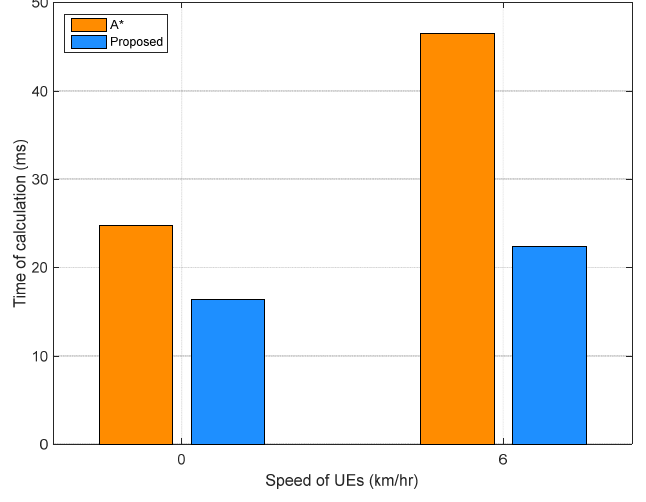
Figure 22. Execution time when UEs are on the move.